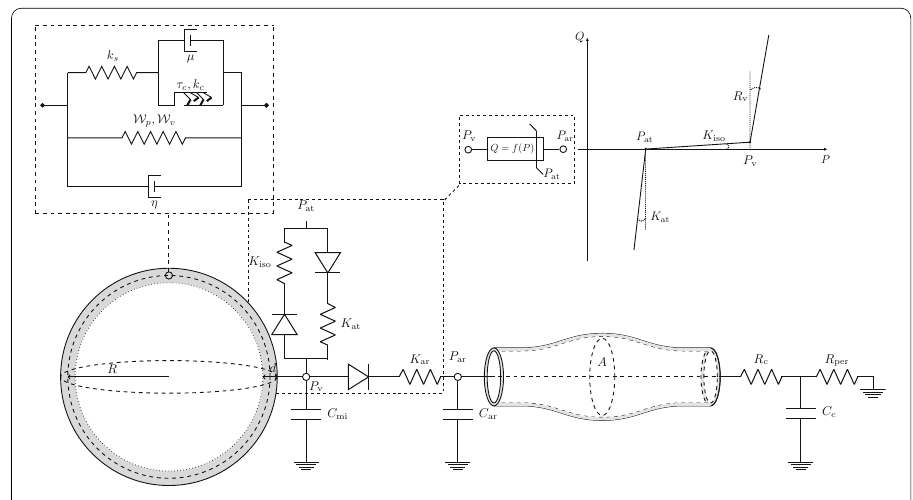
Fig. 2 Complete scheme of the coupled system including the heart, the cardiac valve and the arterial segment. Note that in the upper right plot we have R v : = K ar K iso / ( K ar + K iso ). This model will later be referred to as the